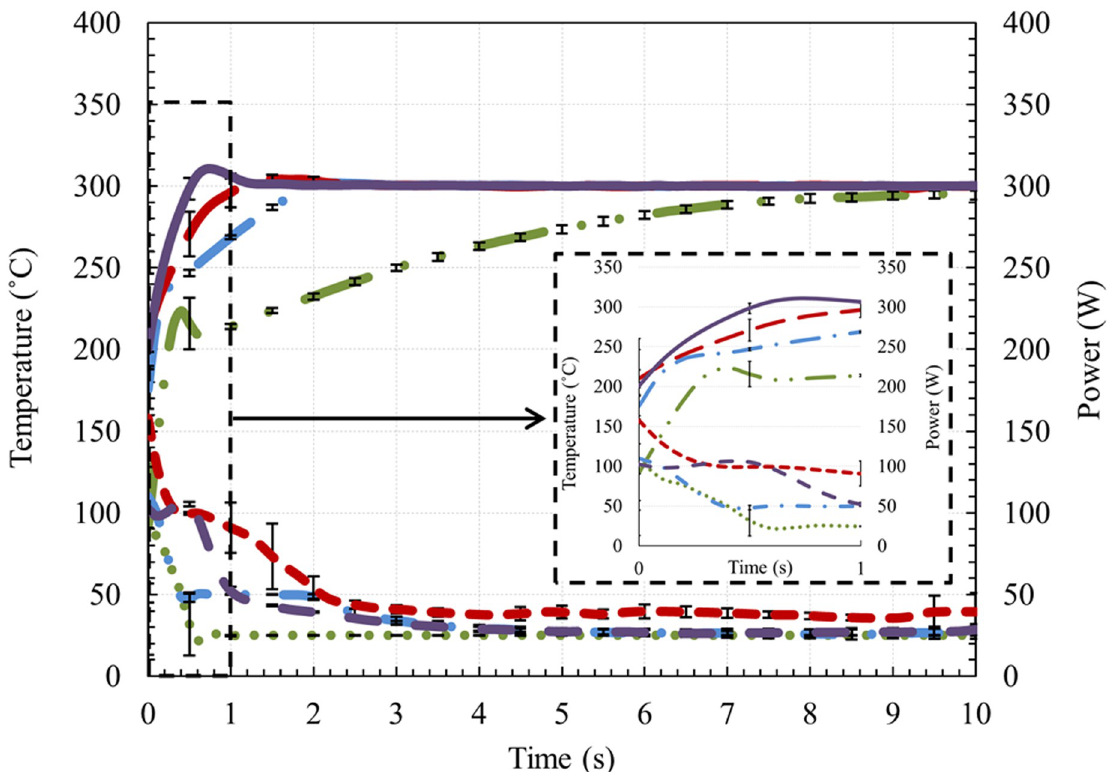
Fig 2. Coil temperature and corresponding power recorded by the EScribe software for the 25 W, 50 W, 100 W, and 200 W power settings. Long dash dot dot green line: temperature for 25 W setting, long dash dot blue line: temperature for 50 W, long dash red line: temperature for 100 W, solid purple line: temperature for 200 W, round dot green line: power for the 25 W setting, dash dot blue line: power for the 50 W setting, square dot red line: power for 100 W setting, dashed purple line: power for the 200 W setting. The inset image shows a magnified section of the graph from 0–1 s; the inset uses the same line descriptions in the caption